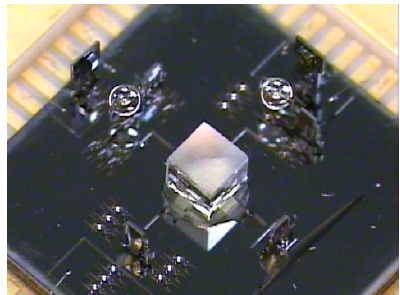
Figure 27. Fully assembled electrothermal actuator-based FTS. (Reprinted with permission from Reference [50] IEEE).